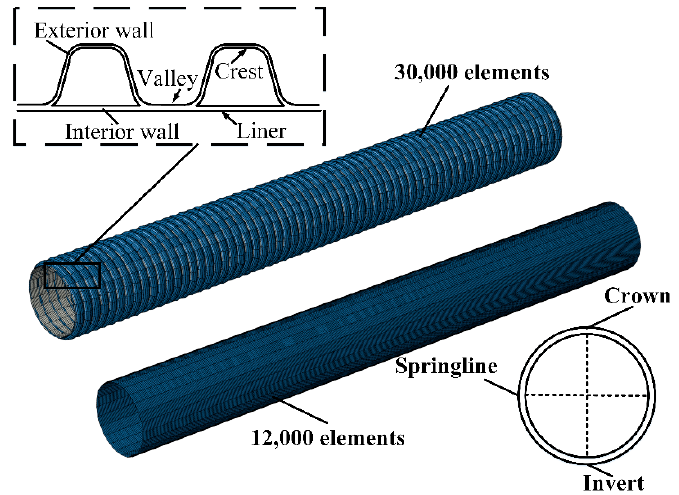
Figure 2. Element numbers of double-wall corrugated pipe and straight-walled pipe. Table 1. Shape parameters of the simplified straight-walled pipe.